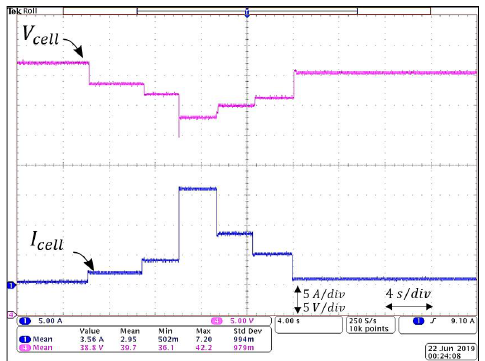
Figure 7. Dynamic response of the Fuel cell (FC) with respect to load variations.